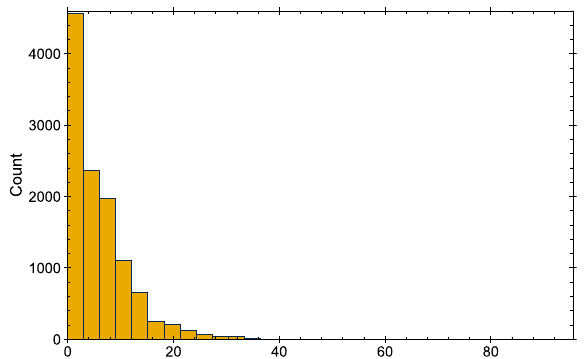
Figure 3. Histogram of the hardness values estimated using The hardness calculator for the Materials Project’s database 15